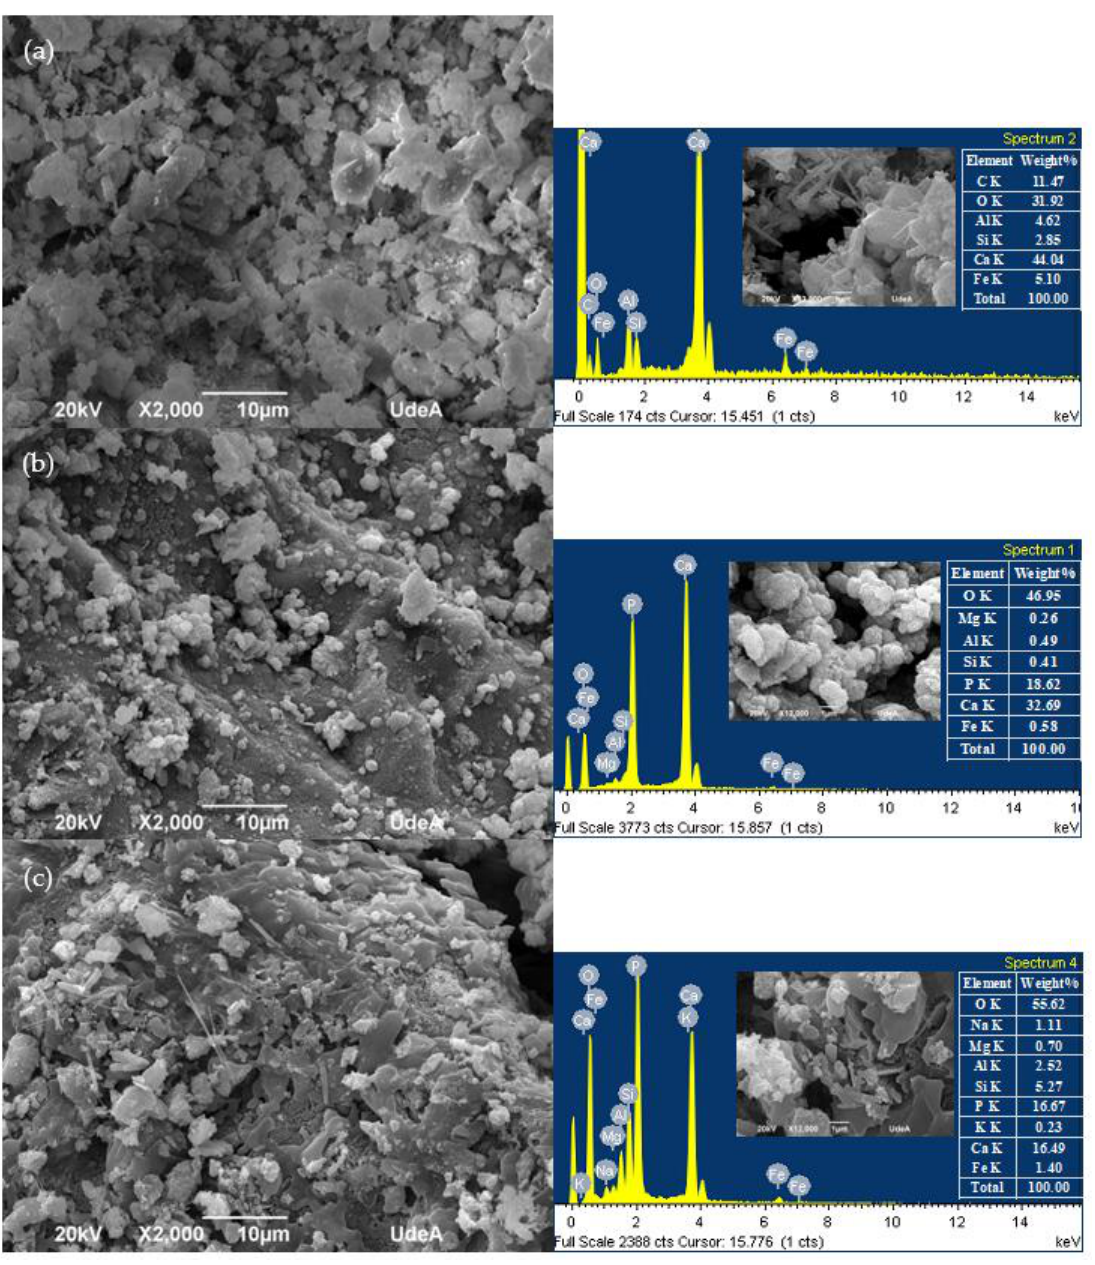
Figure 10. SEM images of the untreated and treated RFA with DAP solution: ( a ) untreated RFA; ( b ) 0.5 mol/L – 7d – 20 °C; ( c ) 2.0 mol/L – 7d – 20 °C.